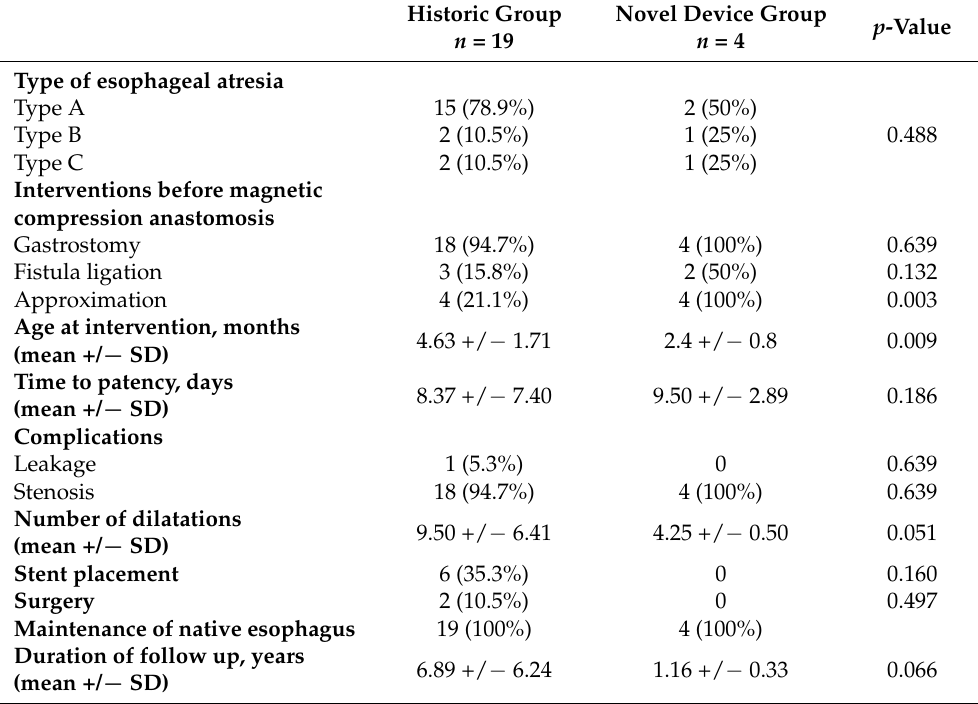
Table 4. Subgroup